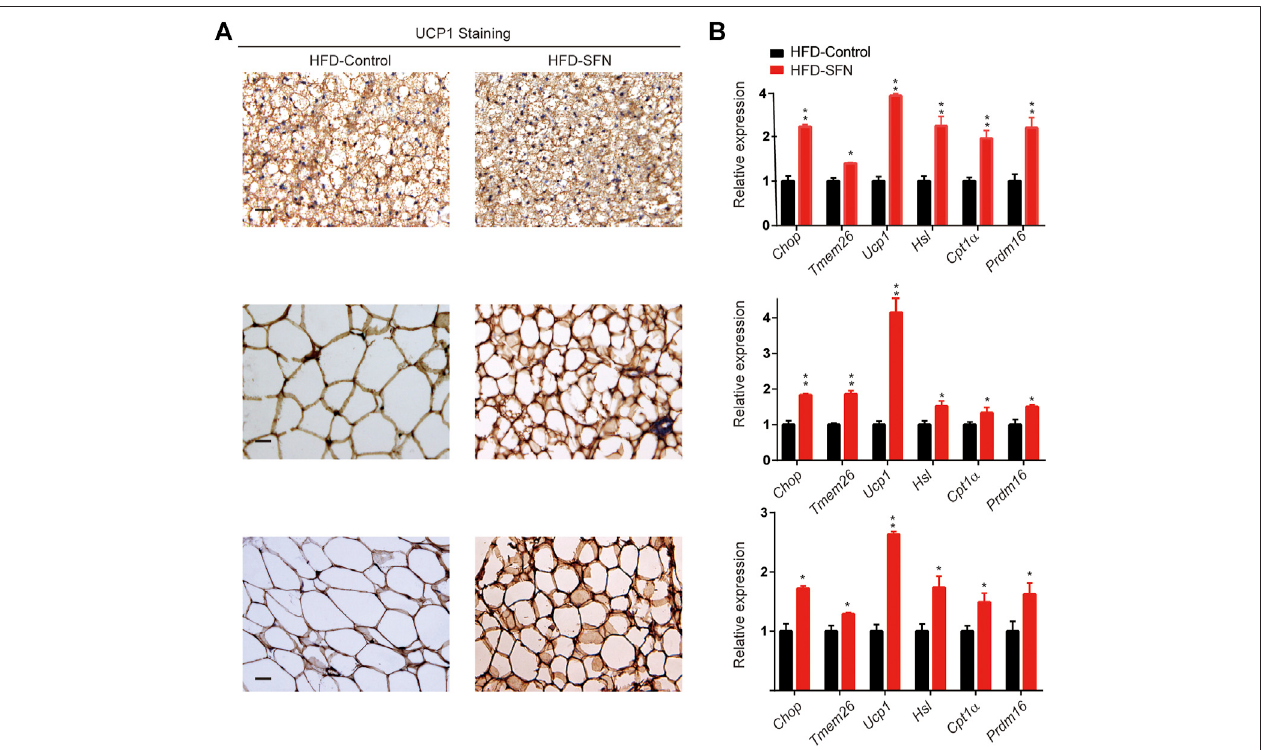
FIGURE7| SFNinducedWATbrowninginHFD-inducedmice. (A) ImmunostainingforUCP1inadiposetissuesectionsofBAT,IWAT,andVWATfromexperiment mice. (B) SFN enhanced the expression of browning genes in BAT, IWAT, and VWAT as determined by real-time qPCR assay. Scar bar (cid:2) 50 μ m. All the results were expressed in graph with mean ± SD. Statistical signi fi cance was evaluated by Student t test. * and ** represent the signi fi cant difference at p < 0.05, p < 0.001 vs control group.